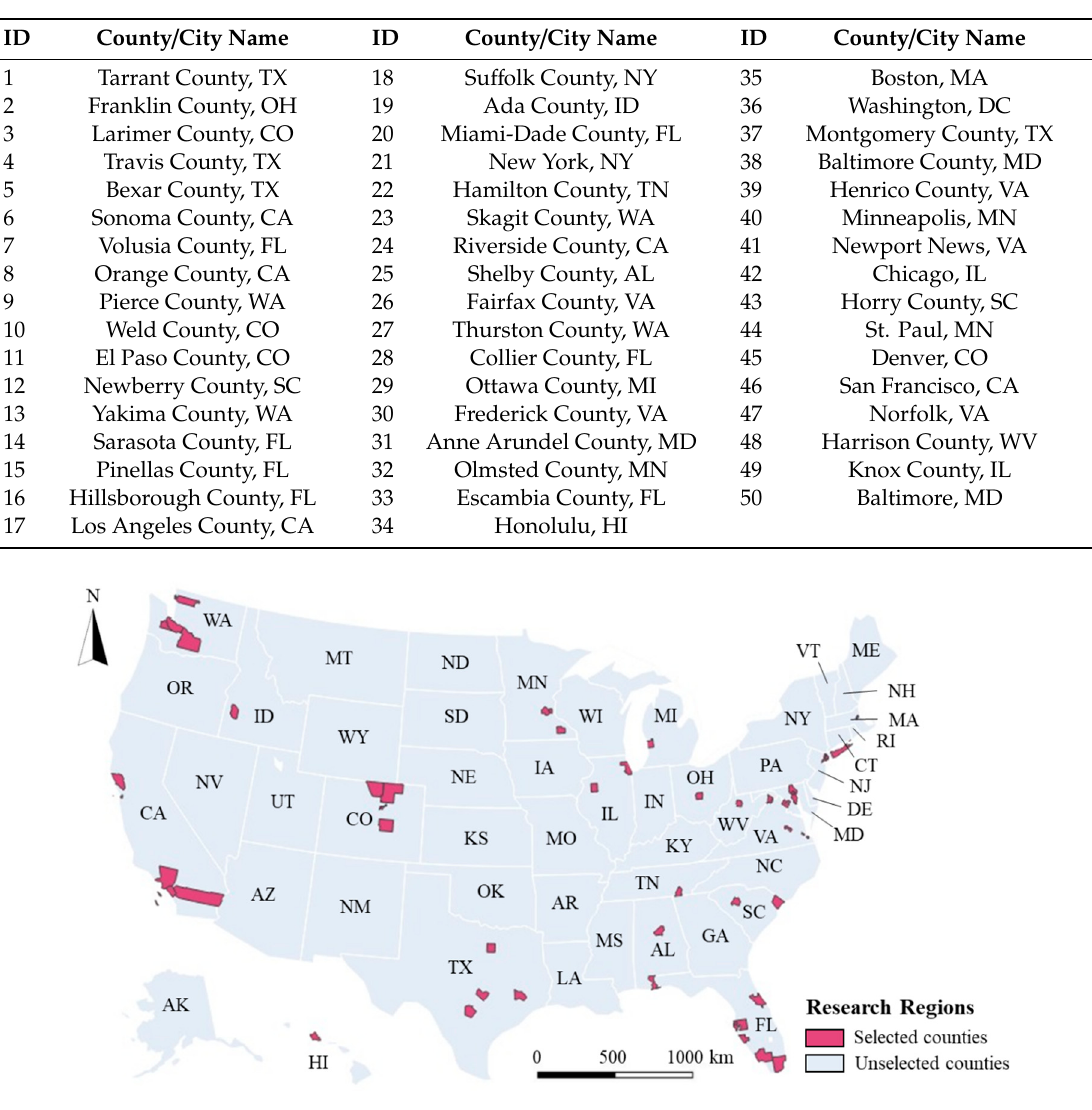
Figure 2. Selected 50 counties regions from SpotCrime website. Table 1. Selected 50 counties/cities list from the SpotCrime website.